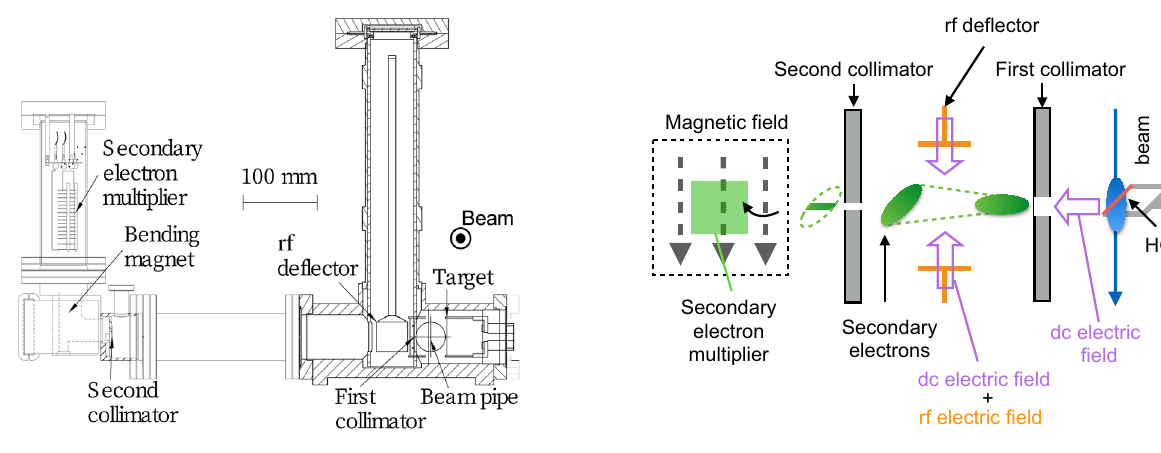
FIG. 4. Schematic of BSM. FIG. 5. Measurement principle of